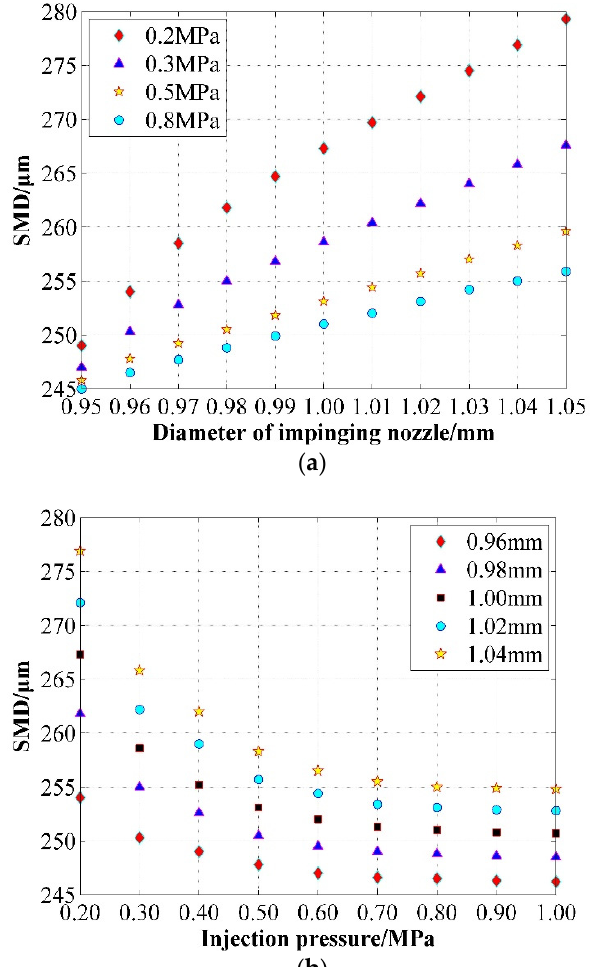
Figure 13. The curves of SMD of atomized droplet with colliding aperture and injection pressure. ( a ) The relationship between SMD and the colliding aperture under different jet pressures. ( b ) The curve of SMD with injection pressure for the small range of collision aperture.